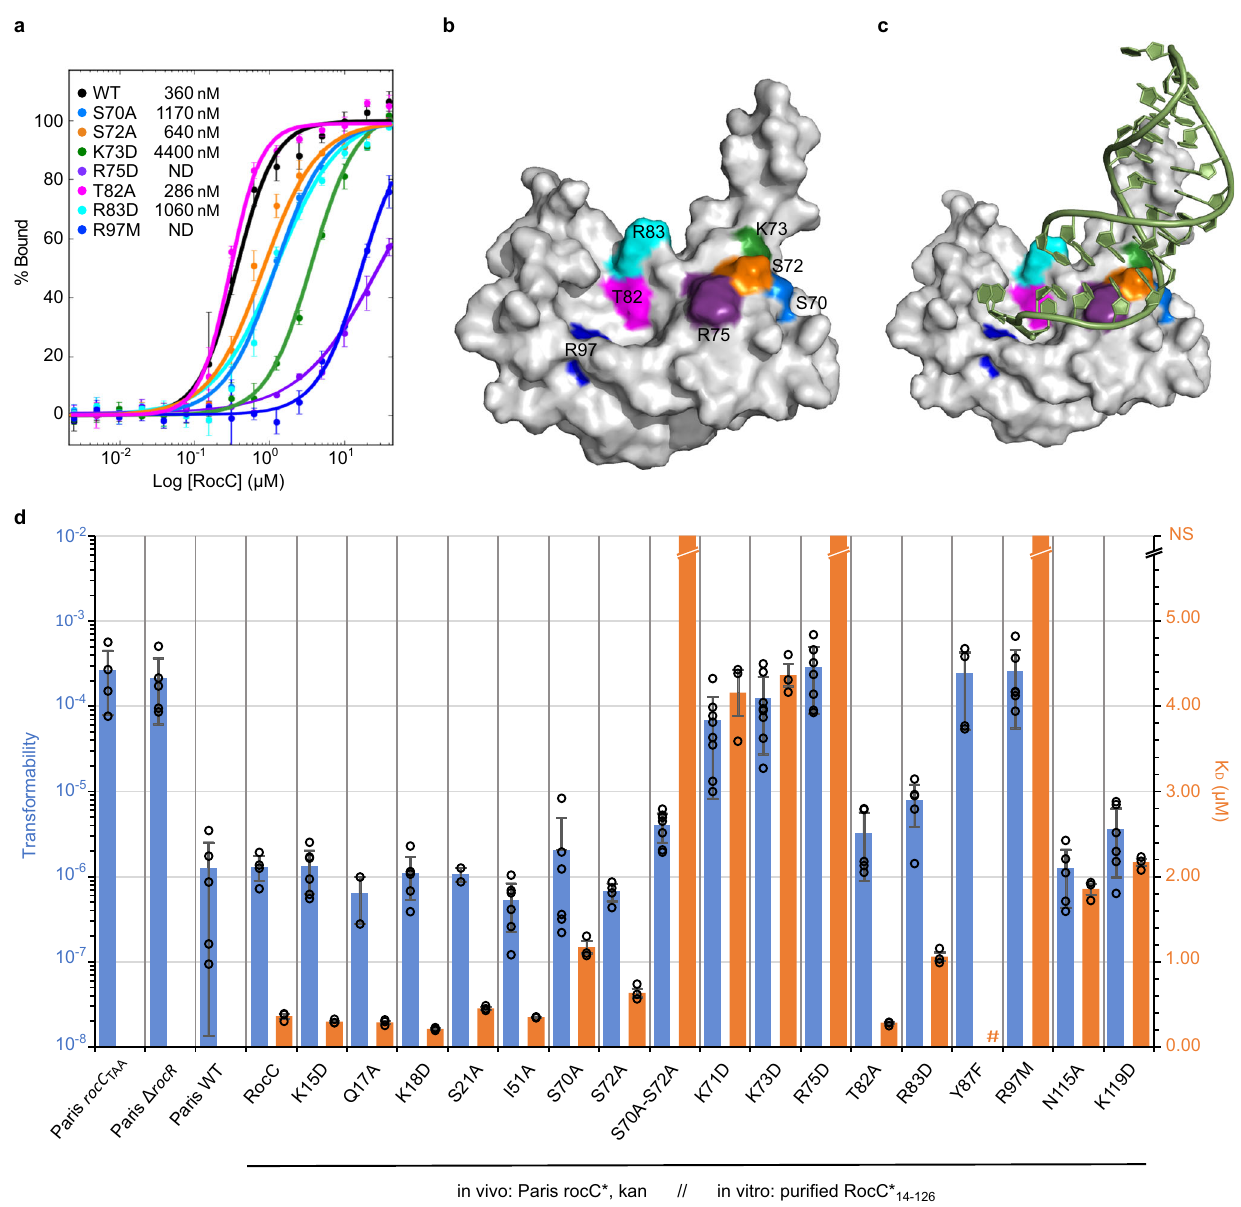
Fig. 4 | Effects of RocC point mutations on RocR binding in vitro and trans- formability in vivo. a FP binding assay for 5 ’ FAM-labeled RocR SL3 with different RocC 14 − 126 point mutants ( n =3). The error bars are standard error of the mean (SEM). b , c SurfacerepresentationofRocC 14 − 126 alone( b )andwithRocR( c )colored to indicate the positions of mutated residues. d A graph displaying RNA-binding af fi nities and transformation ef fi ciencies for the indicated strains and RocC mutants are shown. Orange histograms indicate the K D values measured by FP ( n =3), and the blue histograms indicate the relative transformability of the